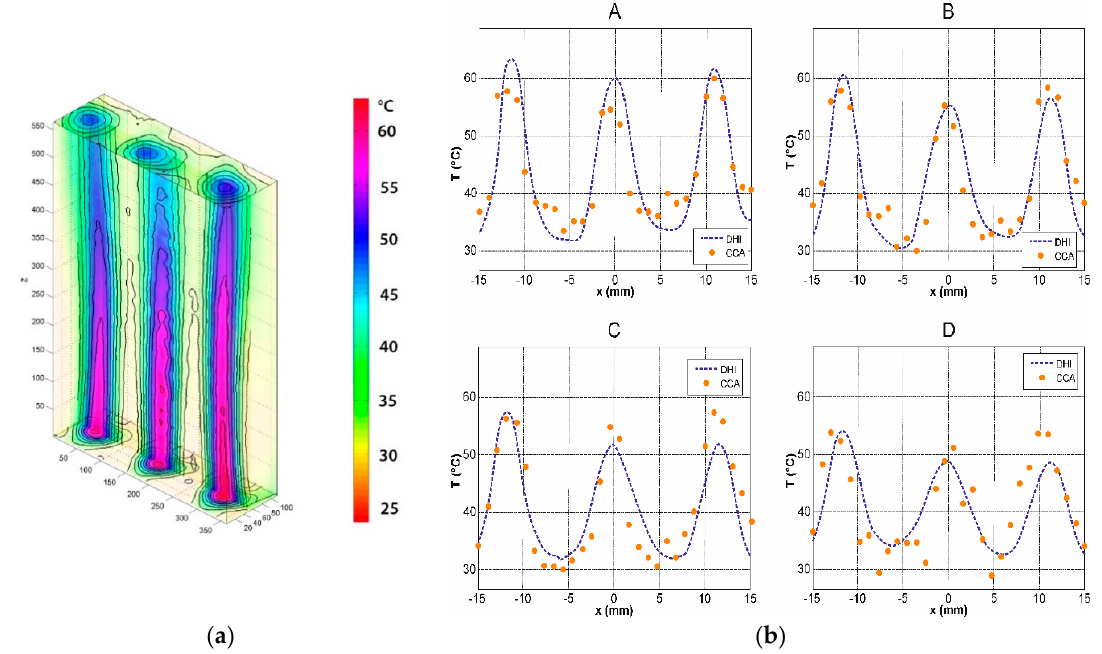
Figure 7. ( a ) Tomographic reconstruction of the temperature field of steady flow, ( b ) temperature profiles measured over a distance of 5 mm ( A ), 10 mm ( B ), 20 mm ( C ), and 40 mm ( D ) from the orifices.